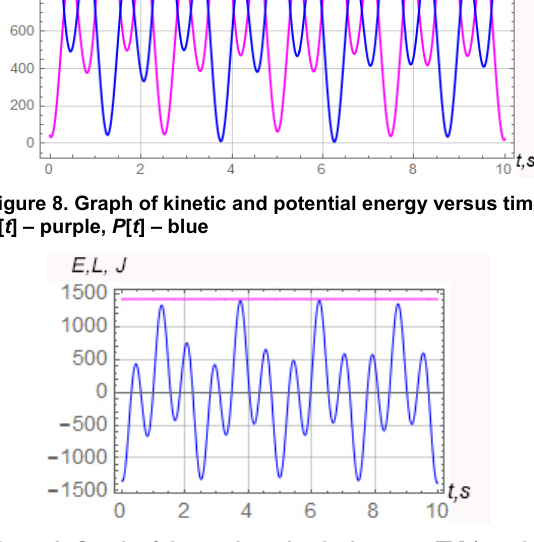
Figure 4. Phase trajectories: a – x 1 - V x 1 , b – x -Vx, c – у - V у